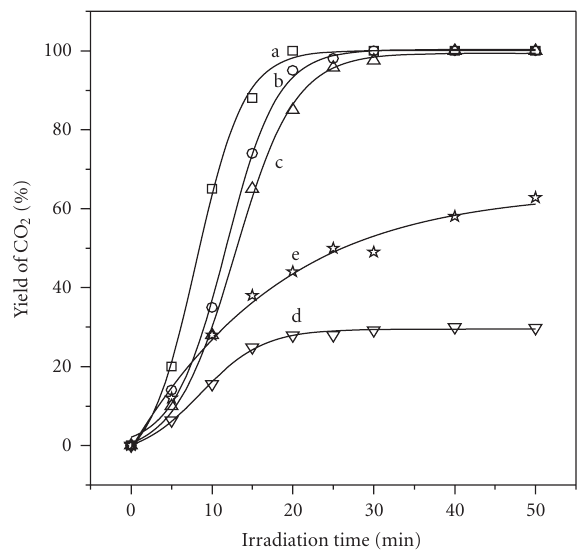
Figure 8: Yield of CO 2 as a function of UV-radiation dose when hy- drothermally synthesized Au/TiO 2 catalyst H3(curves (a)–(d)) and H4 (curve (e)) were employed for vapor-phase photo-oxidation of acetone present at di ff erent concentrations in air. (a) 1.1, (b) 2.5, (c) 4.8, (d) 13, and (e) 3.9 mol%.